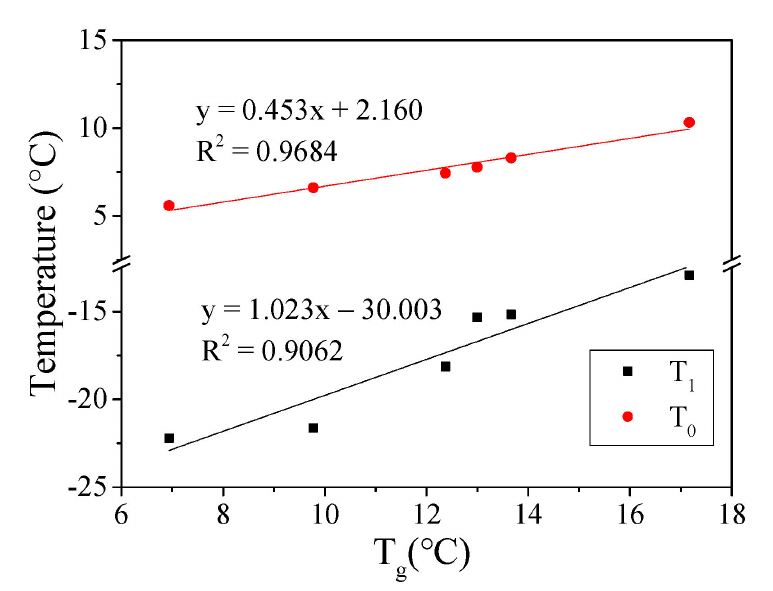
Figure 9. Relationship between T g and T 1 and T 0 .